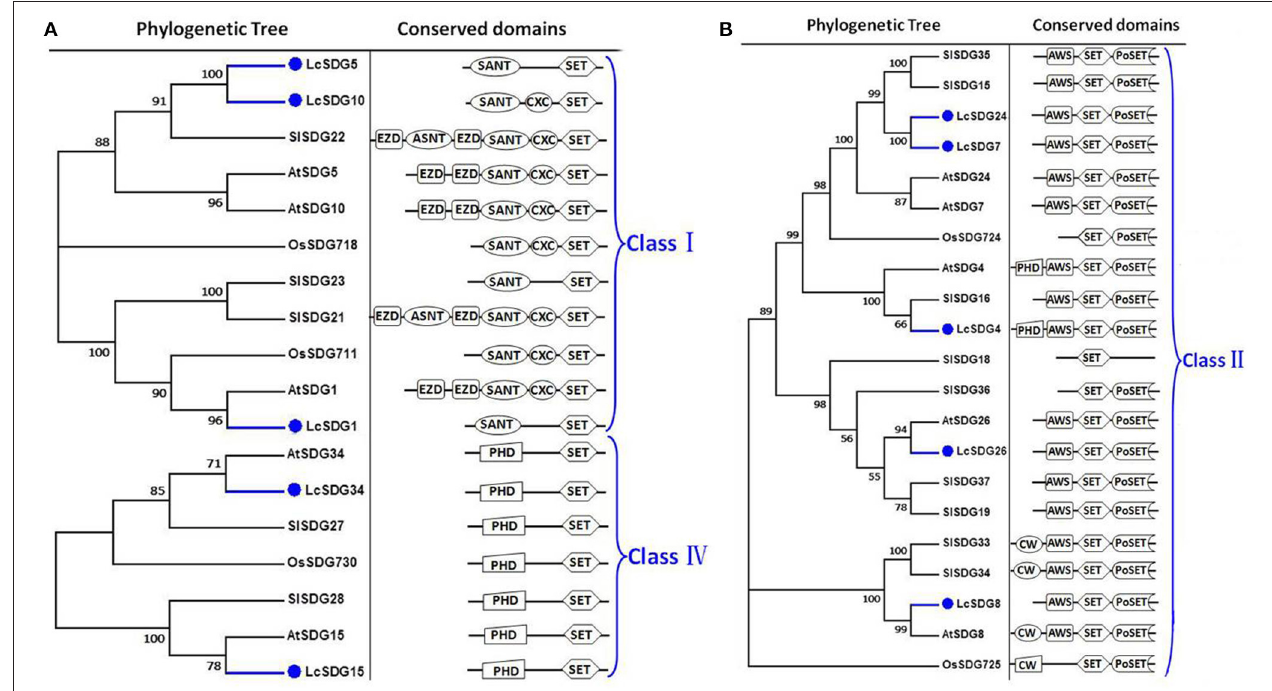
FIGURE 3 | Maximum likelihood phylogenetic trees and schematic diagrams for domain composition of class I, class II, and class IV HMT proteins predicted from Litchi chinensis (Lc), Arabidopsis thaliana (At) , Oryza sativa (Os) , and Solanum lycopersicon (Sl). (A) Phylogenetic trees and schematic diagrams for domain composition of class I and class IV HMT proteins. Two EZD, SANT (SM00717), CXC (PF03638), and SET (PF00856) are conserved domains of Class I. N-terminal PHD and C-terminal SET are conserved domains of Class IV. (B) Phylogenetic tree and schematic diagrams for domain composition of class II HMT proteins. N-terminal AWS (SM00570), SET and Post-SET (SM00508) are conserved domains of Class II. The phylogenetic tree was constructed based on the amino acids sequences with 1,000 bootstrapping replicates.